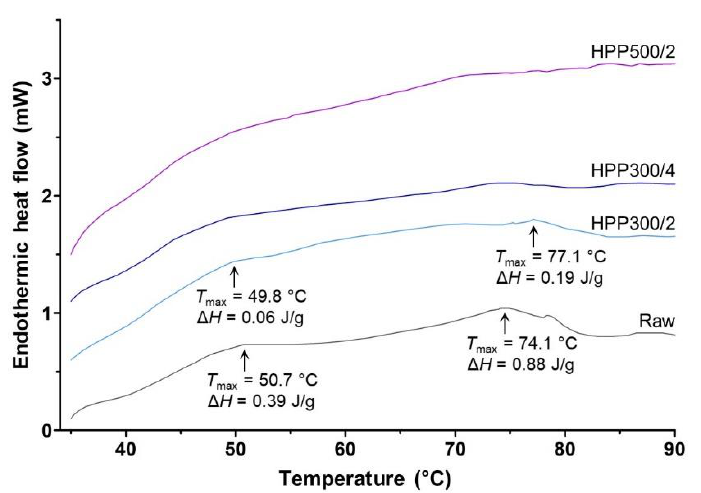
Figure 1. Thermograms obtained from differential scanning calorimetry of meat extracted from raw and high-pressure processed edible crab claws. Detected thermal transition peaks are indicated with arrows accompanied by corresponding protein denaturation temperatures ( T max ) and enthalpy (Δ H ).